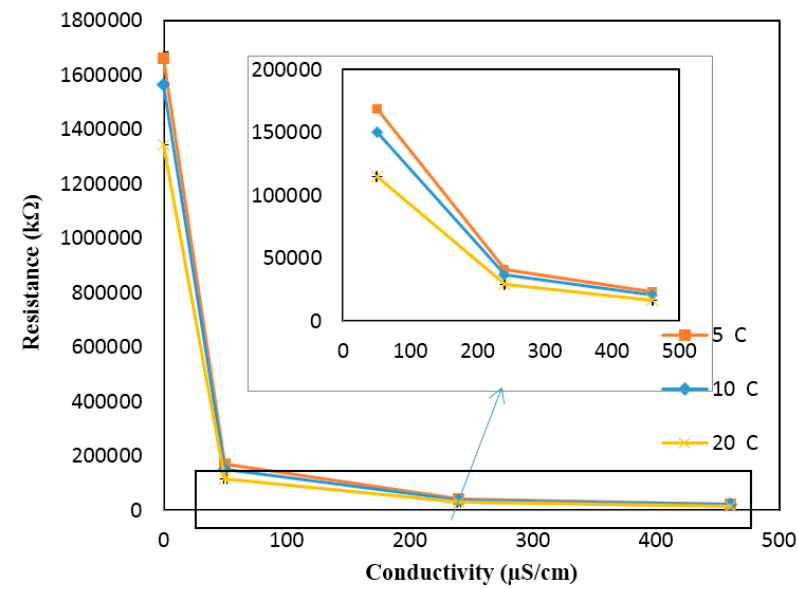
Figure A6. Calibration curve for the conductivity sensor. The inset shows the response of the sensors at high conductivity.